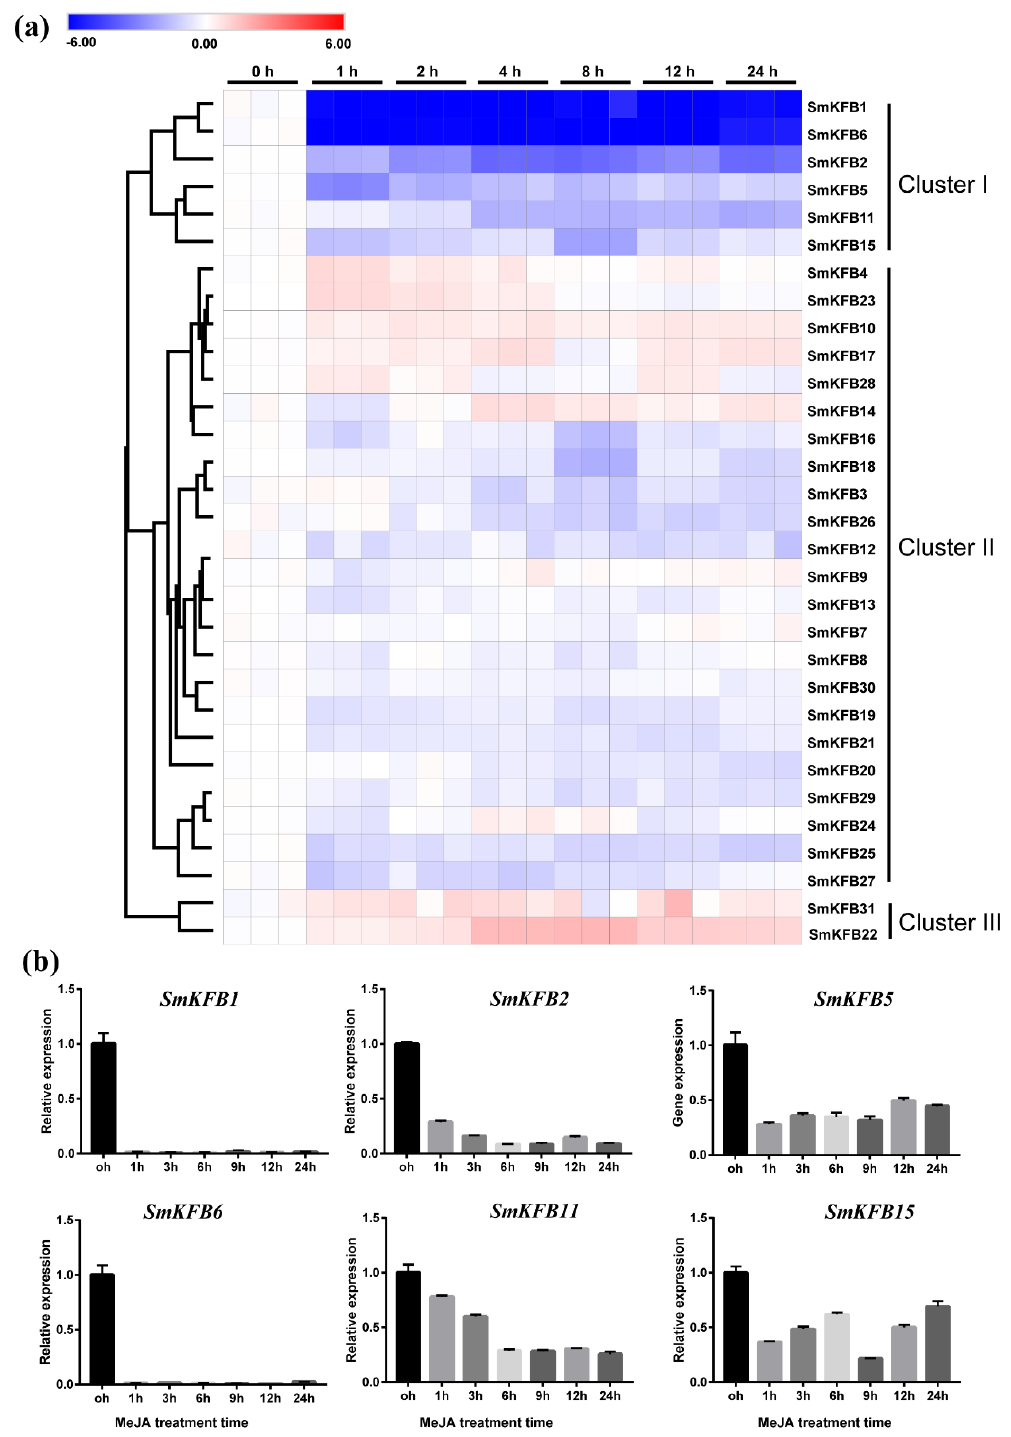
Figure 3. Expression patterns of 31 SmKFB genes in hair roots treated with methyl jasmonate (MeJA). ( a ) The gene expression level was detected via RT-qPCR. The transcripts at the 0 h time point were used as control. Fold change in transcript abundance is illustrated as a heat map on a natural log scale. Blocks with colors indicate low / down expression (blue), high / up expression (red), and non-expression / no change (white). ( b ) Expression patterns of six selected genes in response to MeJA.